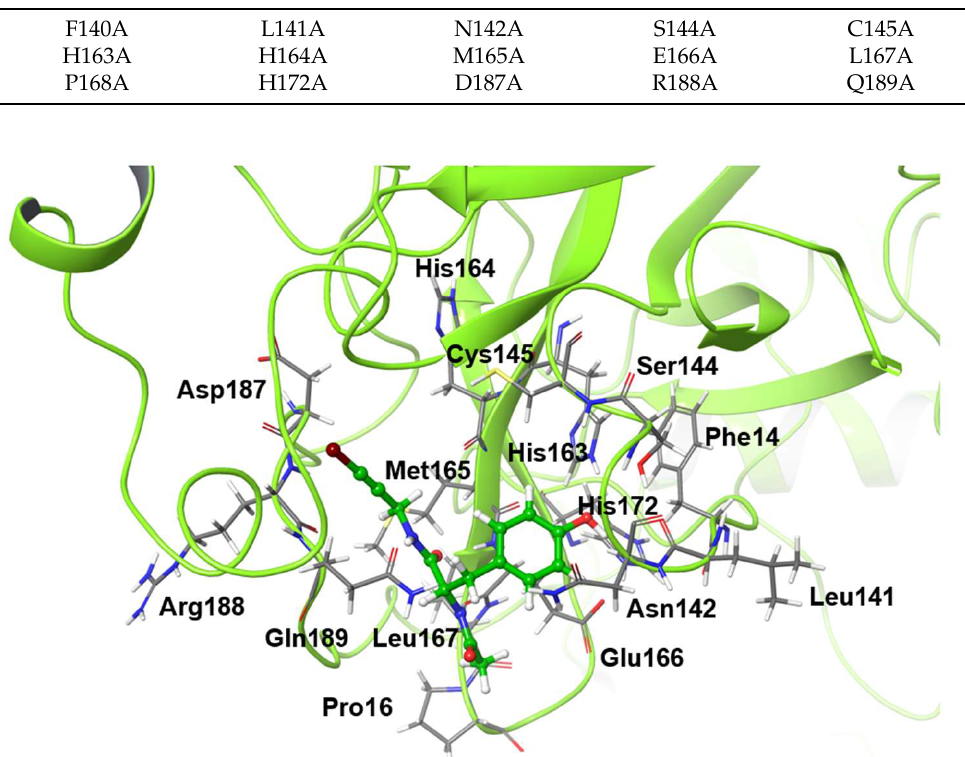
Figure 1. Alanine scanned residues. The molecule drawn as a ball-and-stick model is the inhibitor.